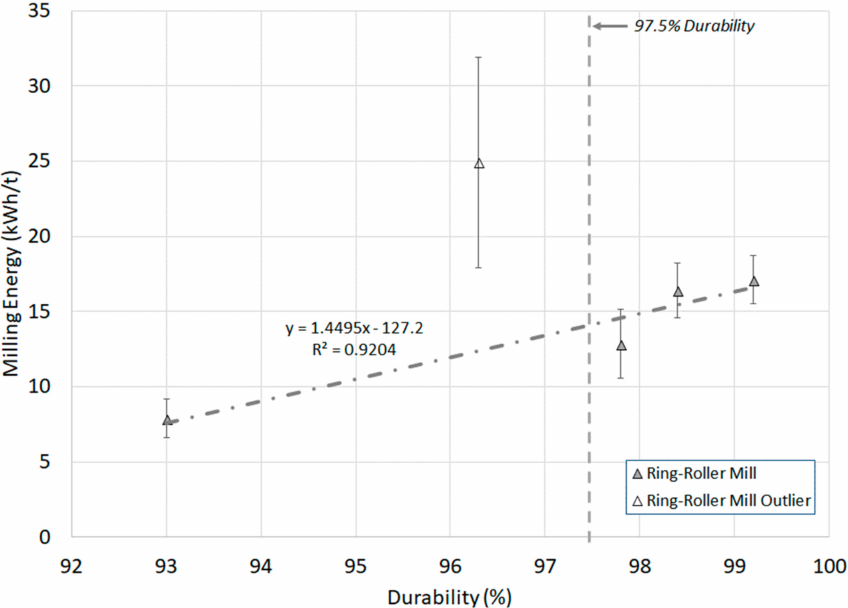
Figure 3. Ring-roller mill energy versus pellet durability. The acceptable limits of durability according to BS EN ISO 17225-2/6 for wood and non-wood pellets are noted. (Milling n = 3, durability n = 2).